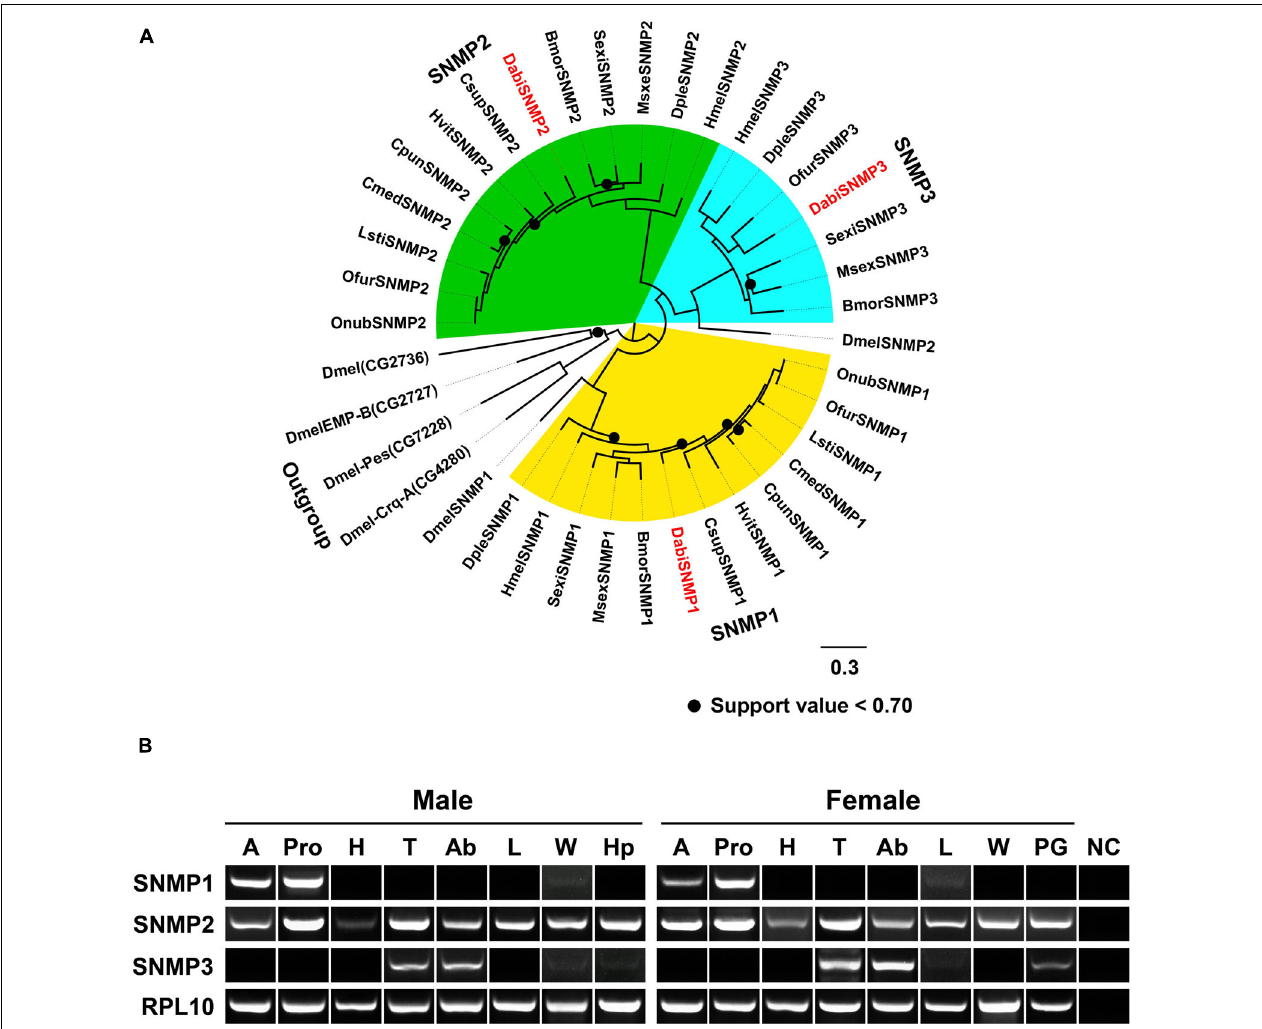
FIGURE 8 | The candidate SNMP gene family in D. abietella . (A) The phylogeny of SNMPs in Lepidoptera and D. melanogaster . DabiSNMPs newly identified in this study are indicated in red. Other members of the CD36 superfamily in D. melanogaster were used to root the tree. (B) Expression profiles of candidate DabiSNMPs in different tissues of D. abietella . The quality and quantity of cDNA templates were measured by a reference gene, DabiRPL10 . NC, negative control using sterile water as the template. The full names of tissues are seen in Table 1 .